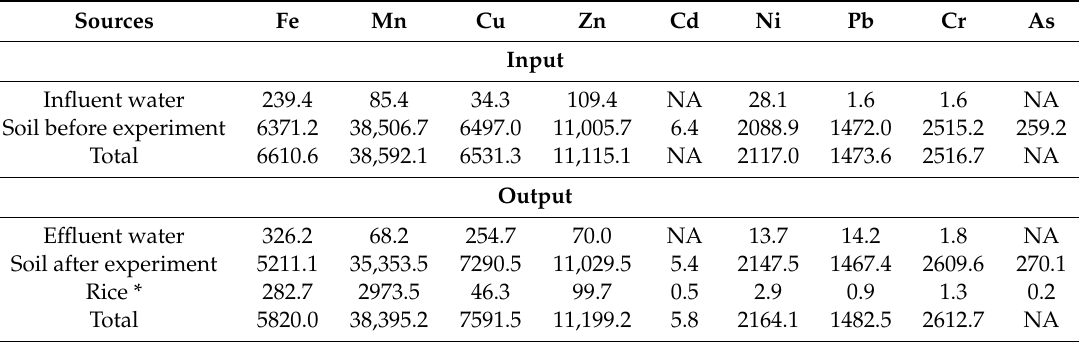
Table 8. Overall mass balances (mg) of heavy metals in the experiment (treatments A, B, C, E, and F). Sources Fe Mn